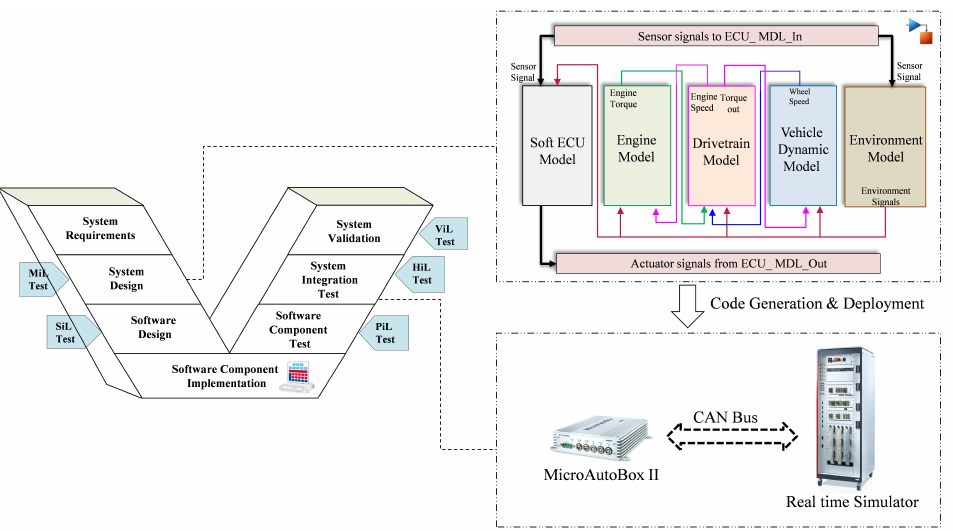
Figure 6. System architecture of the case study with different test phases of